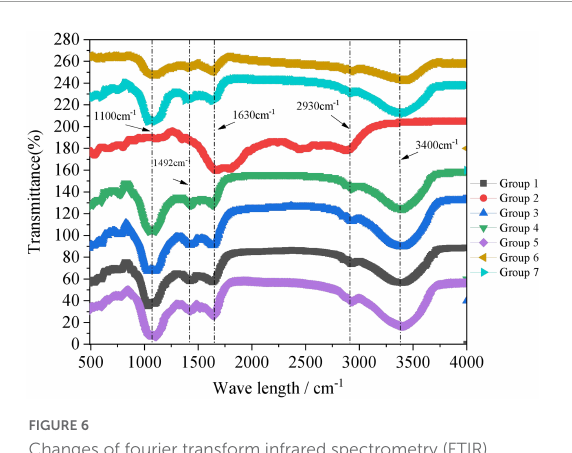
FIGURE6 Changes of fourier transform infrared spectrometry (FTIR) during the aerobic composting progress. The brief description of the symbols in the figures were similar with Figure 1 .